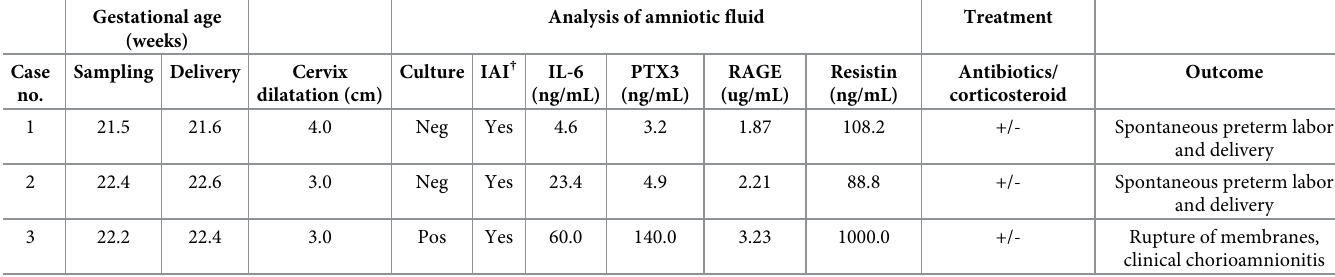
Table 6. Characteristics and outcomes of three patients who delivered within 48 hours after emergency cerclage. Gestational age